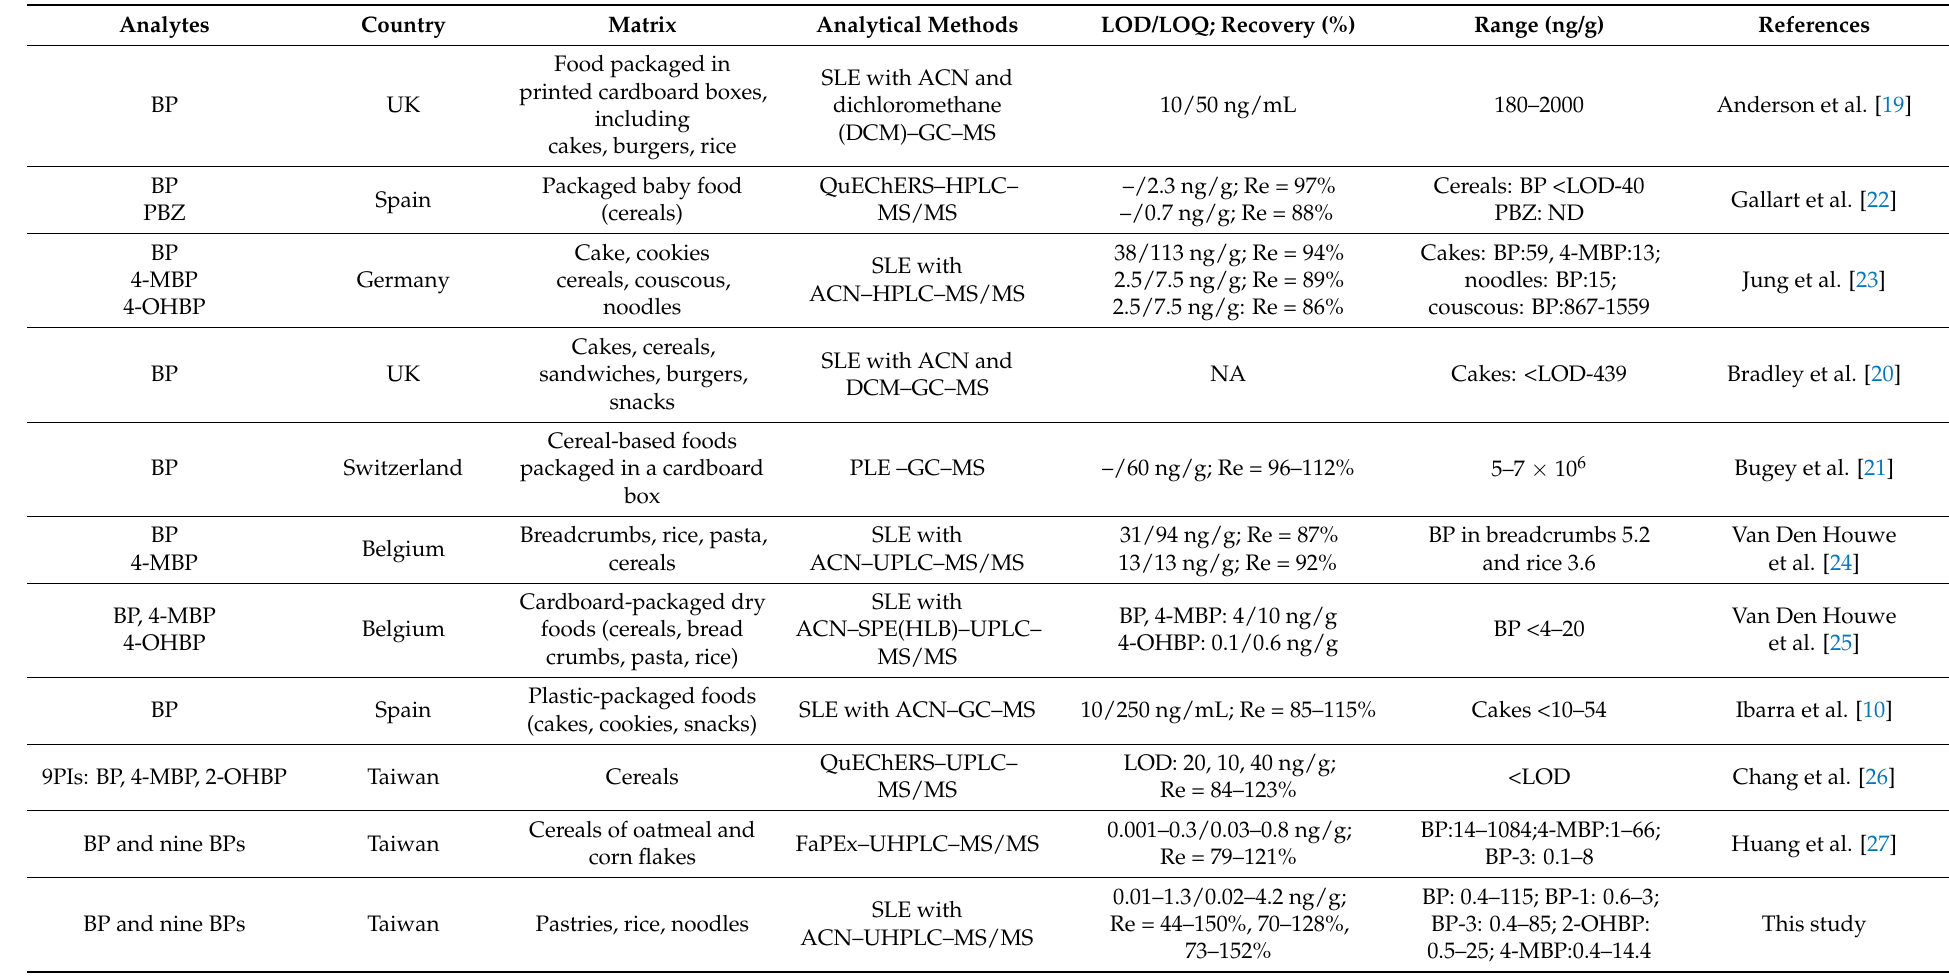
Table 6. Summary of studies reporting the occurrence of BP and BPs in cereal-based foods and a comparison with the analytical